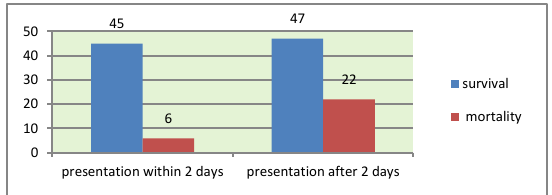
Figure 1: Mortality in neonates who presented within and after 2 days of